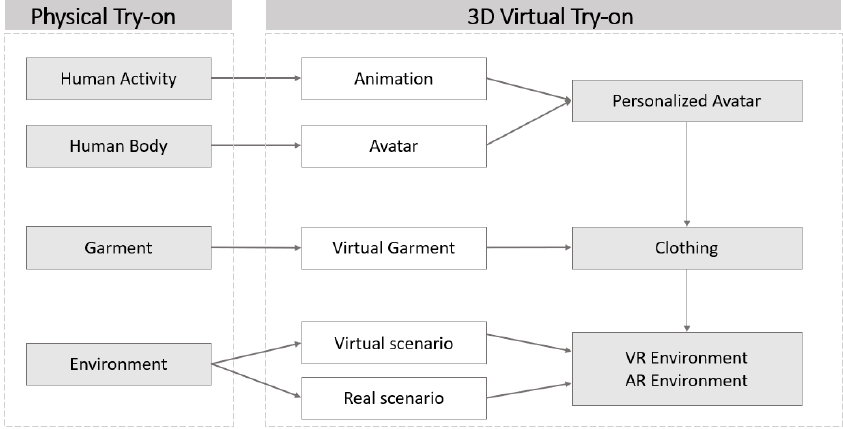
Figure 1. The relationship between physical try-on and virtual try-on